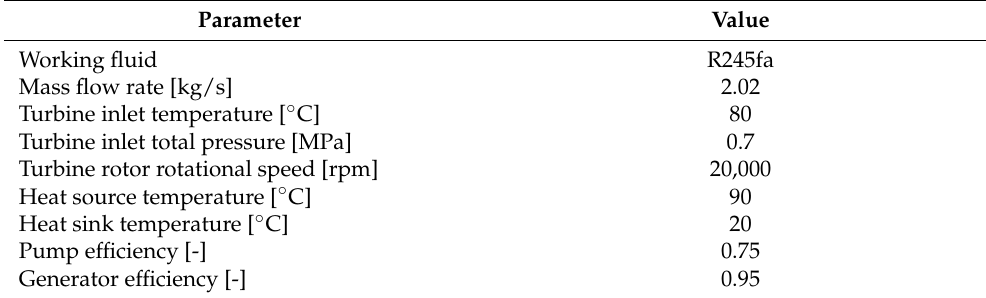
Table 2. Specification of the